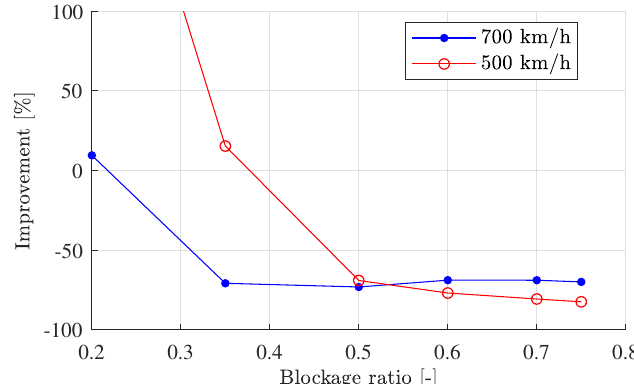
Figure 11. Relative variation of the compressor case with respect to the base case for different blockage ratios and